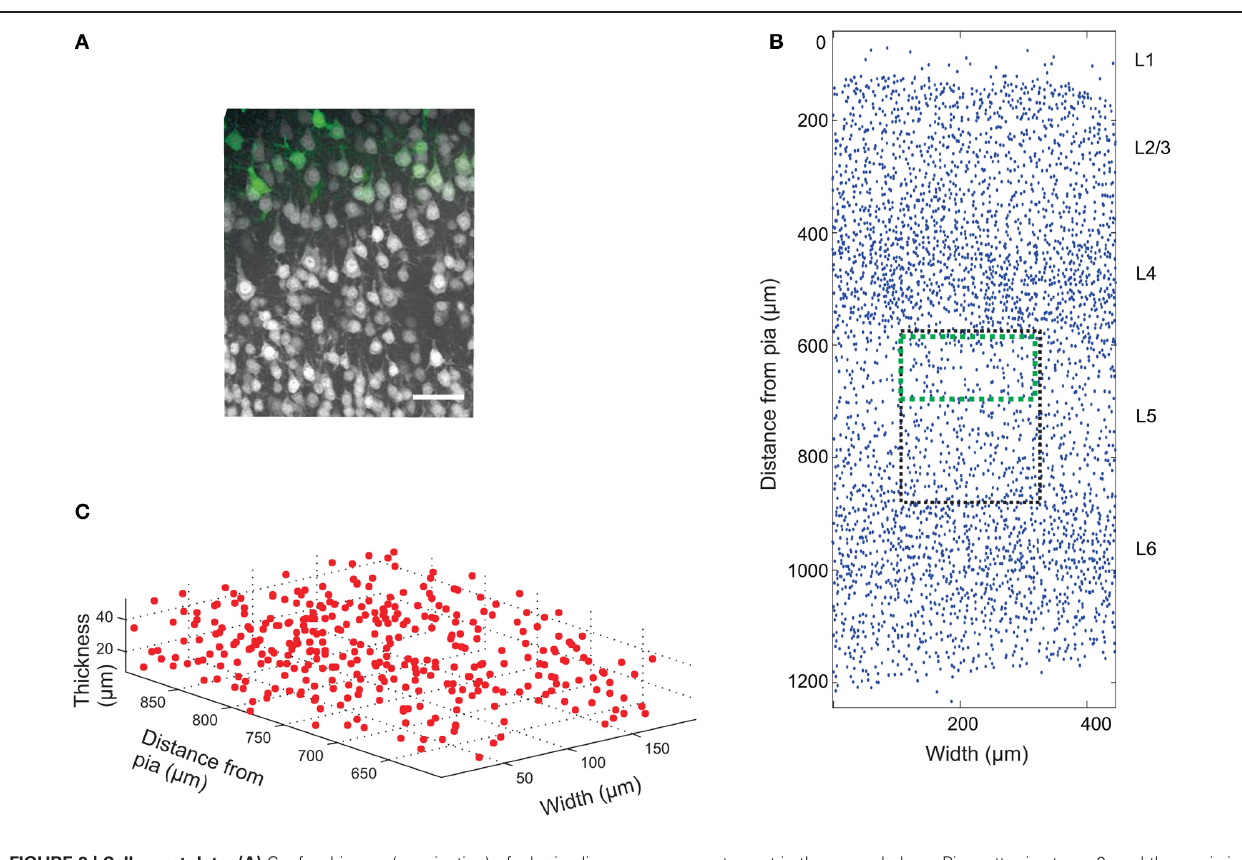
FIGURE 3 | Cell count data. (A) Confocal image (z-projection) of a brain slice showing neurons (gray) labeled with Neuronal Nuclei (NeuN) antibodies, and genetically EGFP-labeled layer 5a corticostriatal pyramidal cells (green). Scale bar 50 μ m. (B) 2D projection of manually placed markers indicating the position of NeuN-labeled cell bodies in a brain slice of the somatosensory